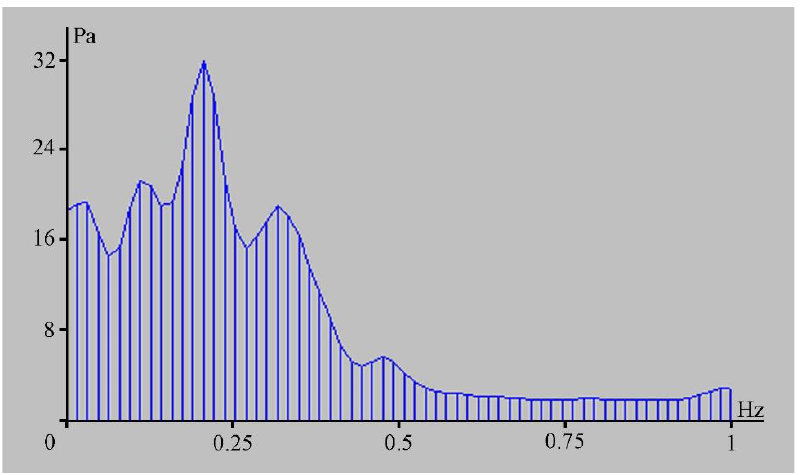
Figure 6. The spectral recording of the supersensitive detector of hydrosphere pressure variations after the disturbance.